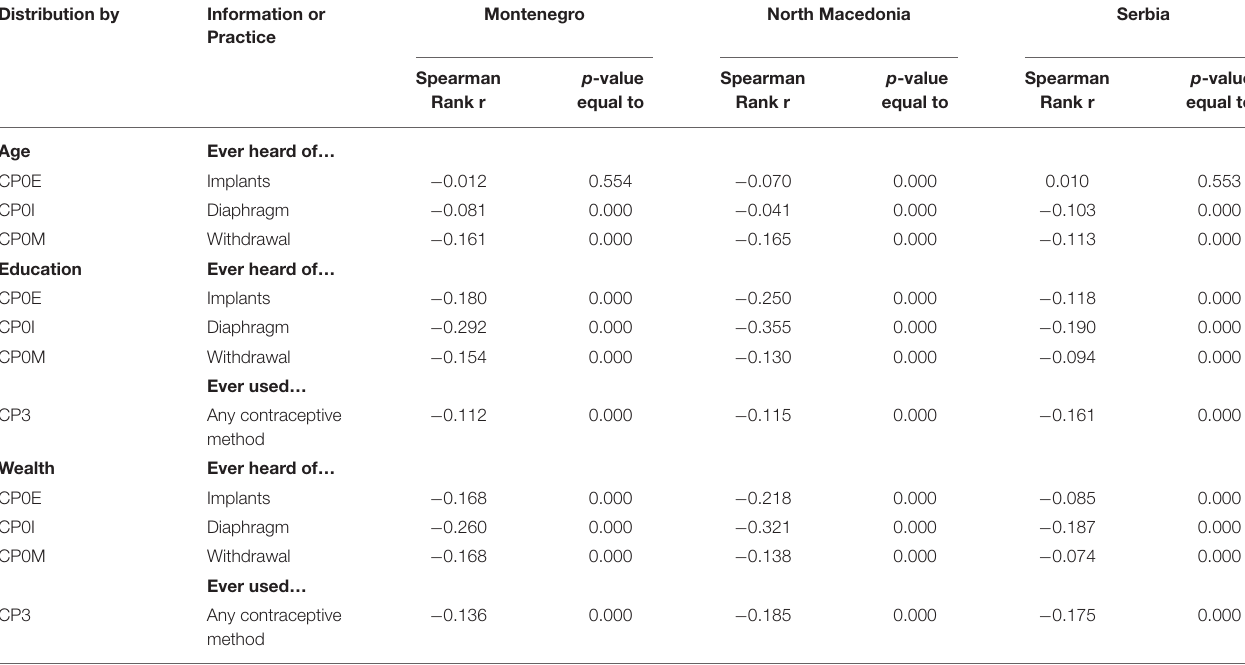
TABLE 4 | Knowledge and use of selected birth control methods. Distribution by